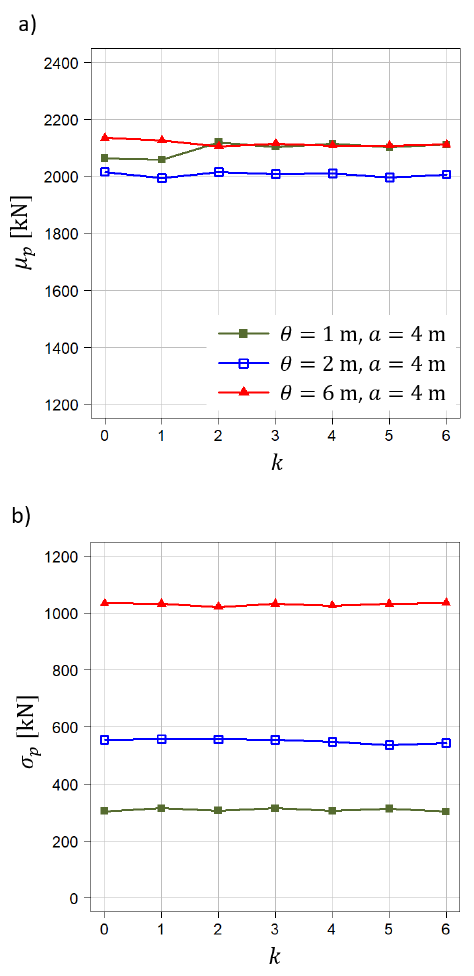
Figure 8: Bearing capacity mean values as a function of covariance matrix iteration number (a). Bearing capacity standard deviation as a function of covariance matrix iteration number (b). Case k =0 is for the constant covariance matrix. Results for a rectangular foundation of size 1 m x 4